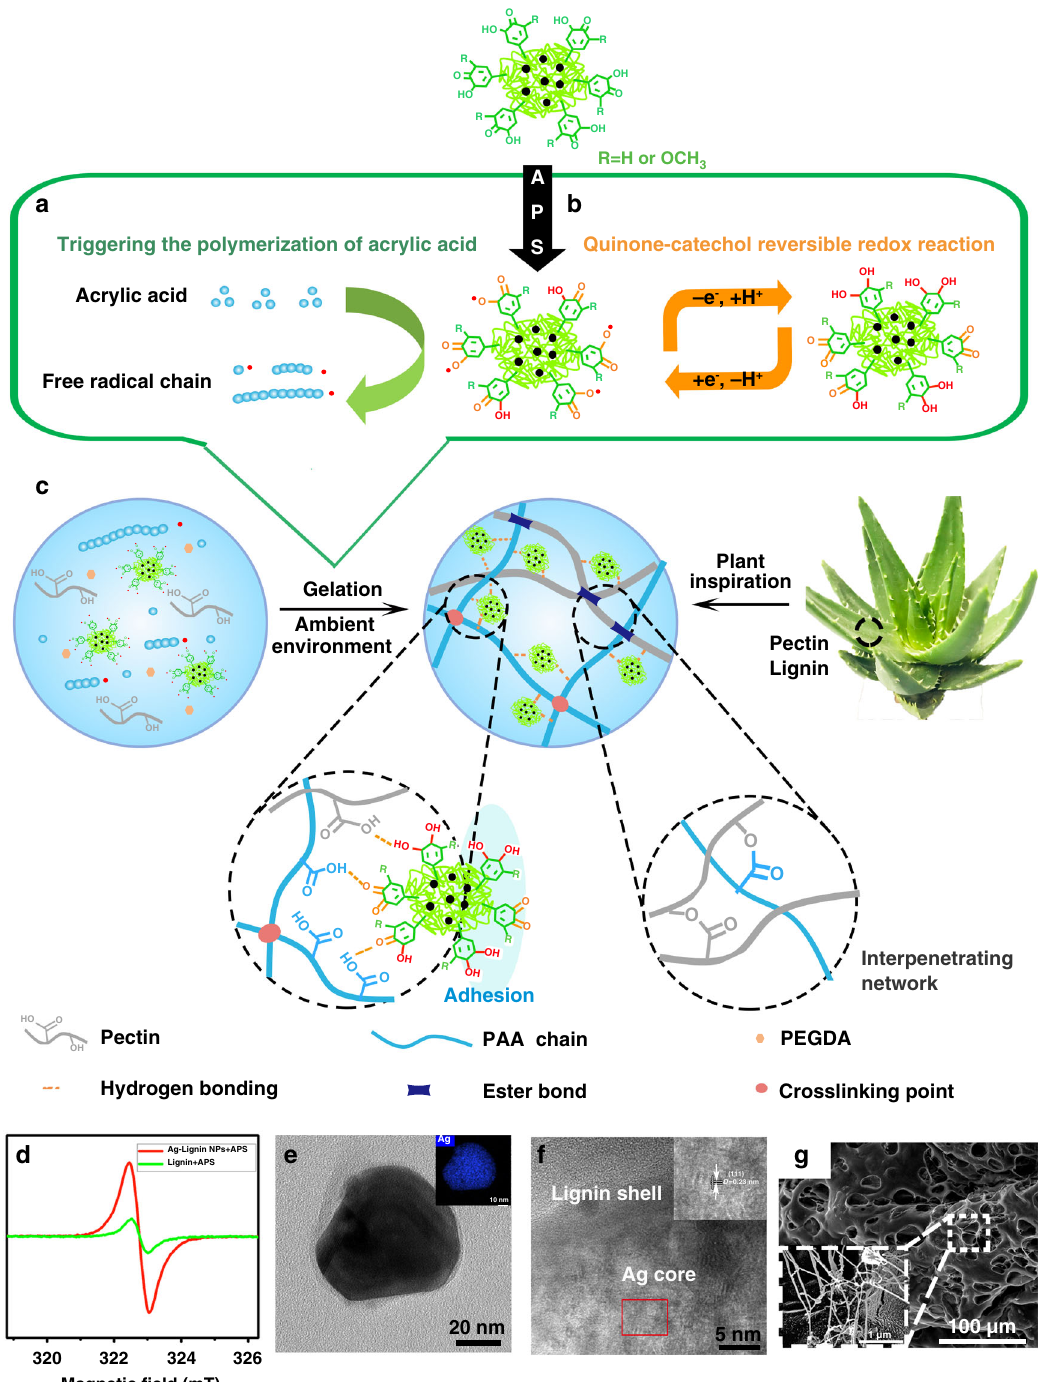
Fig. 1 Design strategy for the plant-inspired catechol-chemistry-based self-adhesive, tough, and antibacterial NPs-P-PAA hydrogel. a Generation of radicals by the redox reaction between Ag-Lignin NPs and ammonium persulfate (APS), triggering the gelation of the hydrogel under an ambient environment. b Quinone-catechol reversible reaction maintains dynamic balance. c Scheme of molecular structure of plant-inspired adhesive and tough hydrogel. d Electron spin-resonance spectroscopy (ESR) spectra for quinone radical detection. e Transmission electron microscope (TEM) micrograph shows the core-shell structure of Ag-Lignin NPs; the inset is Ag element mapping. f High-resolution transmission electron microscopy (HRTEM) micrograph shows the structure of Ag-Lignin NPs; the inset is high-resolution lattice. g Scanning electron microscope (SEM) micrograph shows the micro fi bril structures in the hydrogel; the inset presents typical micro fi brils. NPs, nanoparticles; P, pectin; PAA, polyacrylic